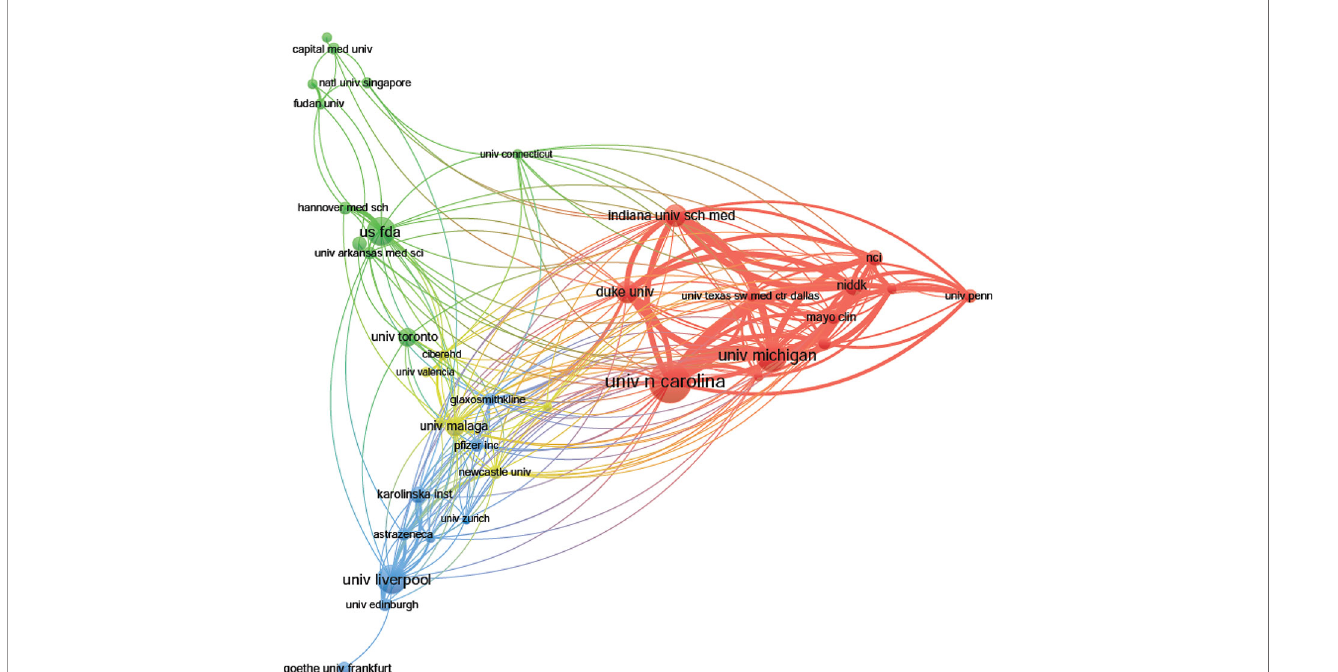
FIGURE 3 | The network map of institutions for drug-induced liver injury (DILI) research (T = 17).